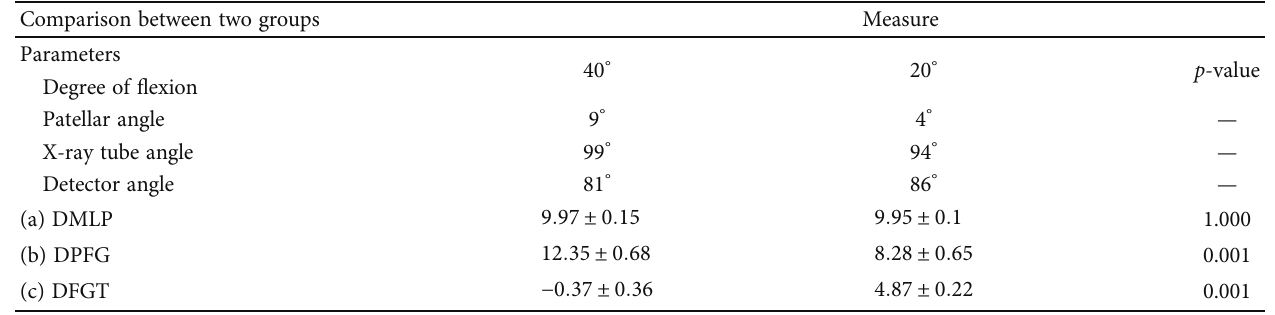
Table 2: Comparison of PJR images taken at 40 ° and 20 ° of knee fl exion angles.